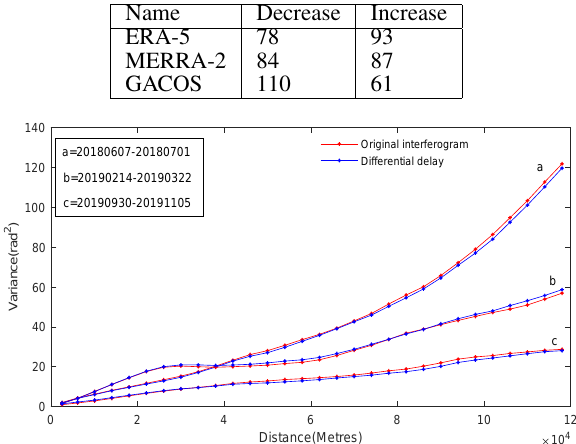
Figure 9. An example of spatial dependence between short interval interferograms and their corresponding SAR-based differential